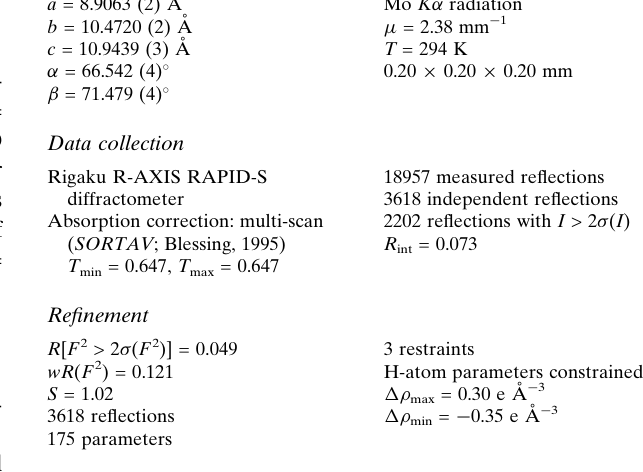
Data collection